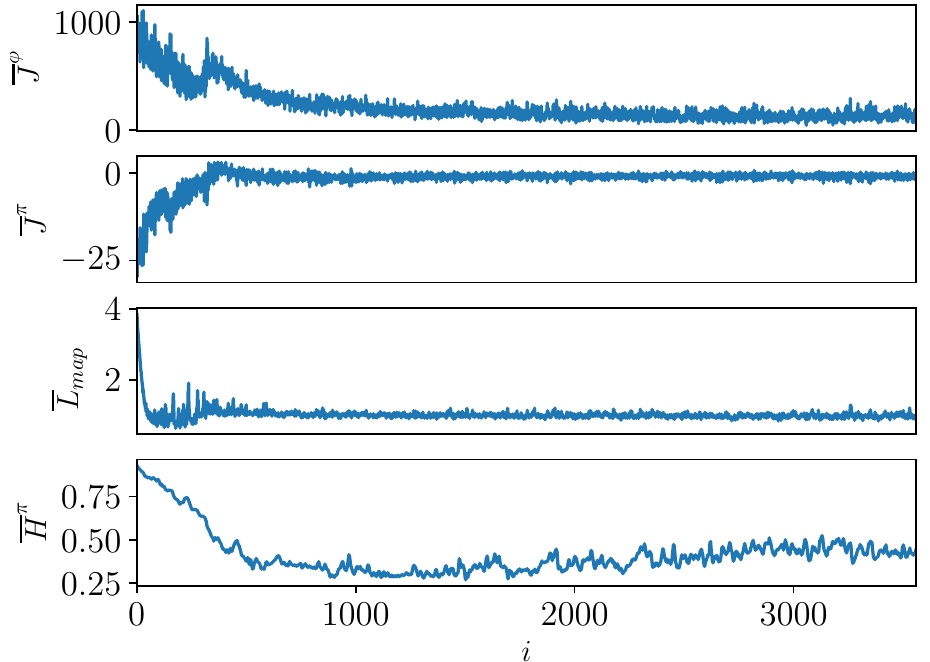
Figure 11. A3C training variables evolution: in the top row for the average of the advantage loss J φ ; in the second row for the average of the policy loss J π ; in the third row for the average of the “map loss” L map ; in the bottom row for the average of the normalized entropy H π .